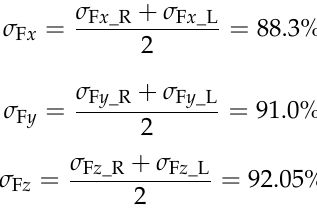
The Number of Cycles That Satisfy Both the Mean Range and the Amplitude